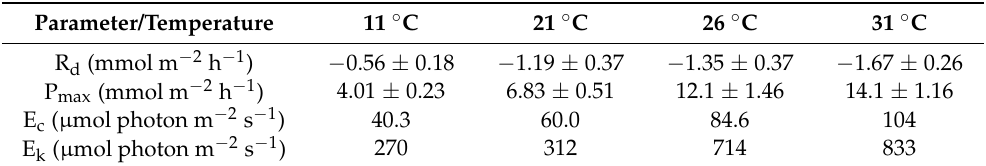
Table 1. Photosynthetic parameters of Pneophyllum fragile at 11–31 ◦ C. Factors: R d (respiration in the dark), P max (maximum photosynthesis capacity), E c (compensation irradiance), and E k (saturating irradiance).